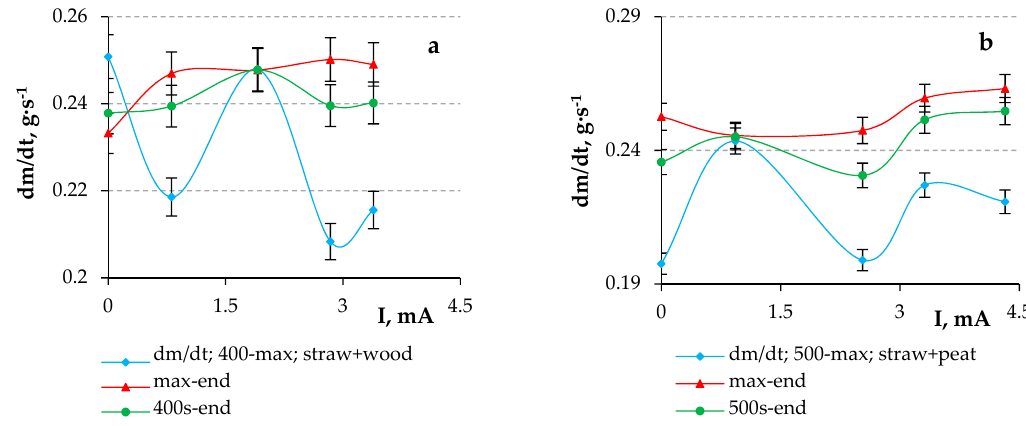
Figure 7. Electric field effect on the biomass pellet mixture mass loss rate at thermal decomposition when co-firing straw with wood ( a ) or with peat ( b ).